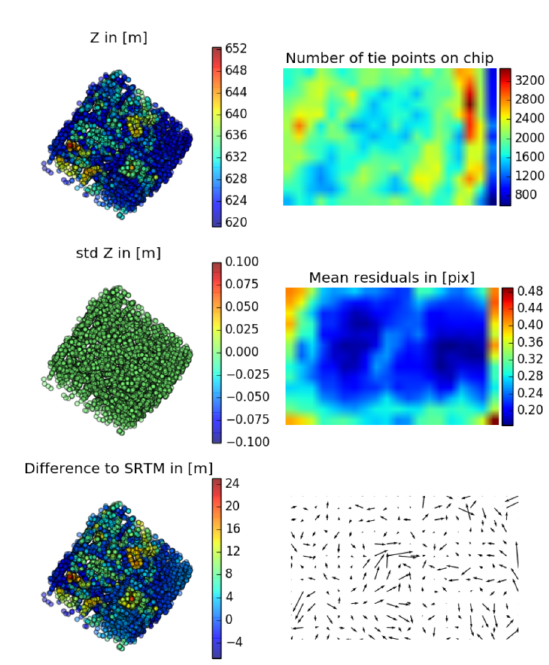
Figure 7. Results of the bundle block adjustment in test area A (counterclockwise from upper left): absolute height of tie points in m, standard deviation of height at tie points, difference of the absolute height to the global SRTM DSM, quiver map of mean residuals at the sensor chip, mean residuals at the sensor chip and distribution of tie points at the sensor chip.